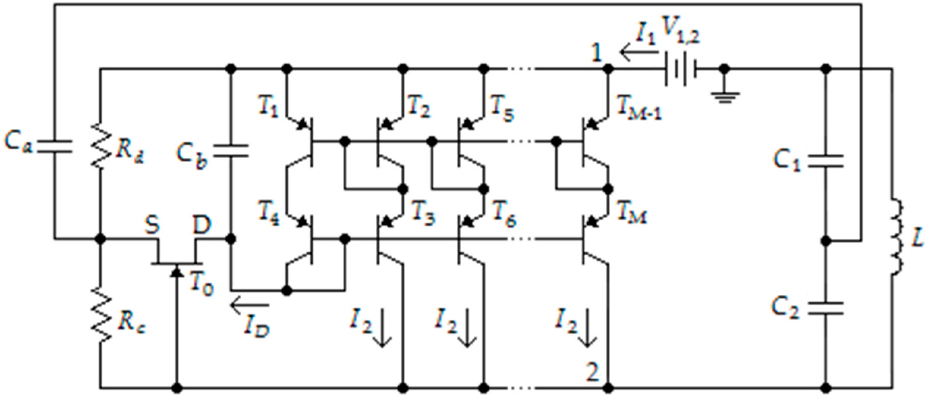
Figure 8. NDR oscillator with multiple-output improved Wilson current mirror.